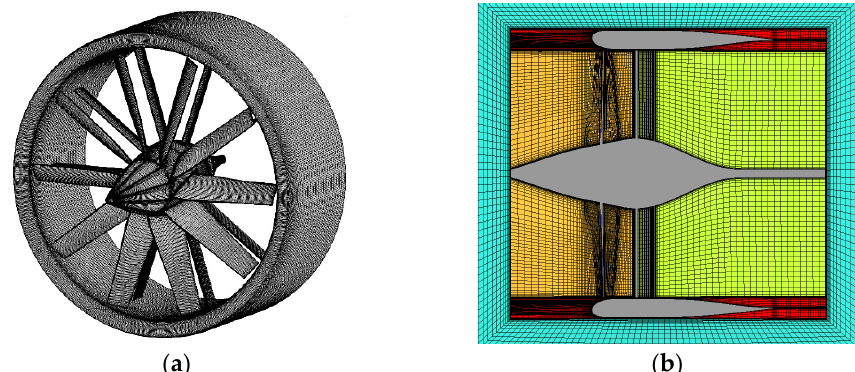
Figure 11. Fan disc mesh model at 0.08 L axial position. ( a ) The surface mesh on the duct wall, fan blade, and stator blade. ( b ) The structure of multi-layer sliding mesh along the axial direction. Table 7. Results comparisons of fan disc at 0.08 L and 0.2 L axial positions.